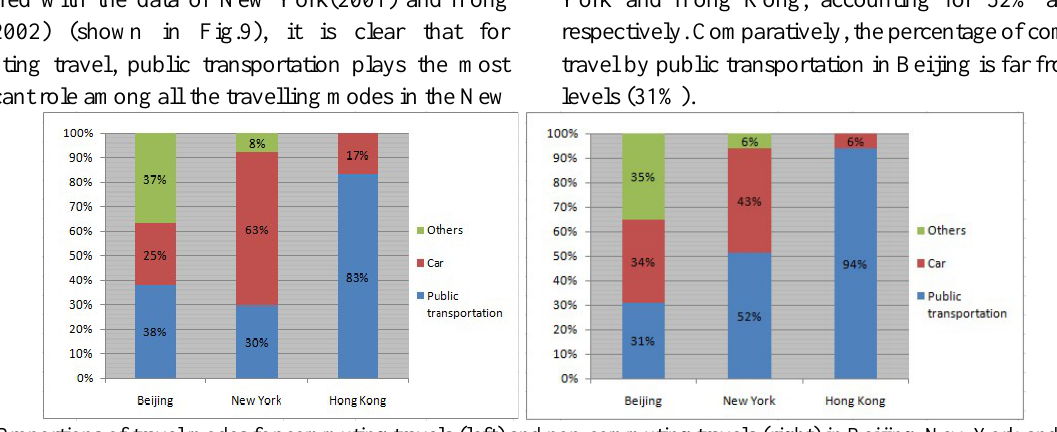
Fig. 9. Proportions of travel modes for commuting travels (left) and non-commuting travels (right) in Beijing, New York and Hong Kong Source: Annual Report of Beijing Transport Development (2006); National Household Travel Survey New York Add-On (2001); Hong Kong Travel Characteristics Survey (2002)